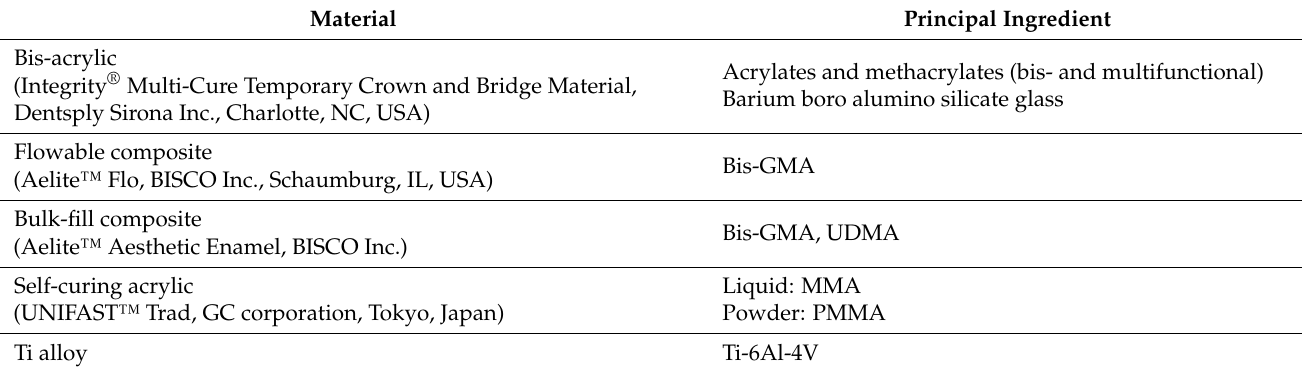
Table 1. Materials used in this